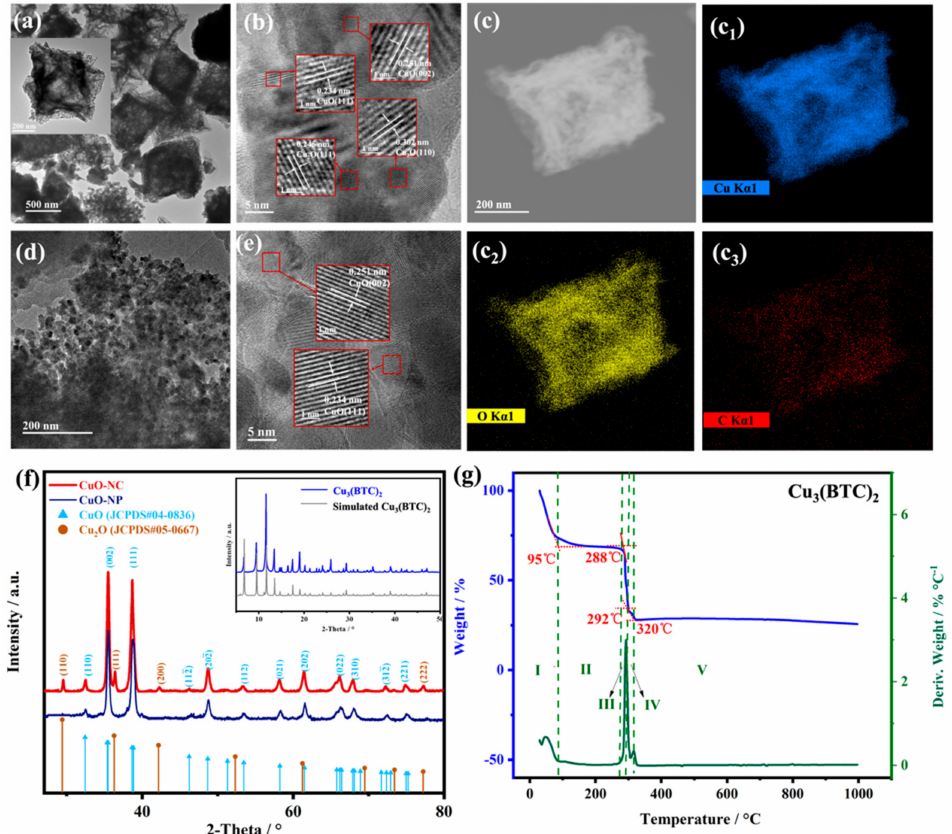
Figure 1. The morphology and phase of nano − CuOs. TEM images of ( a , b ) CuO − NC and ( d , e ) CuO − NP. The inset of ( a ) is the corresponding magnified image; STEM image ( c ) and elemental mapping images ( c1 – c3 ) of CuO − NC; XRD patterns of ( f ) Nano − CuOs and (inset) Cu 3 (BTC) 2 ; and ( g ) TGA and DTA curves of Cu 2 (BTC) 3